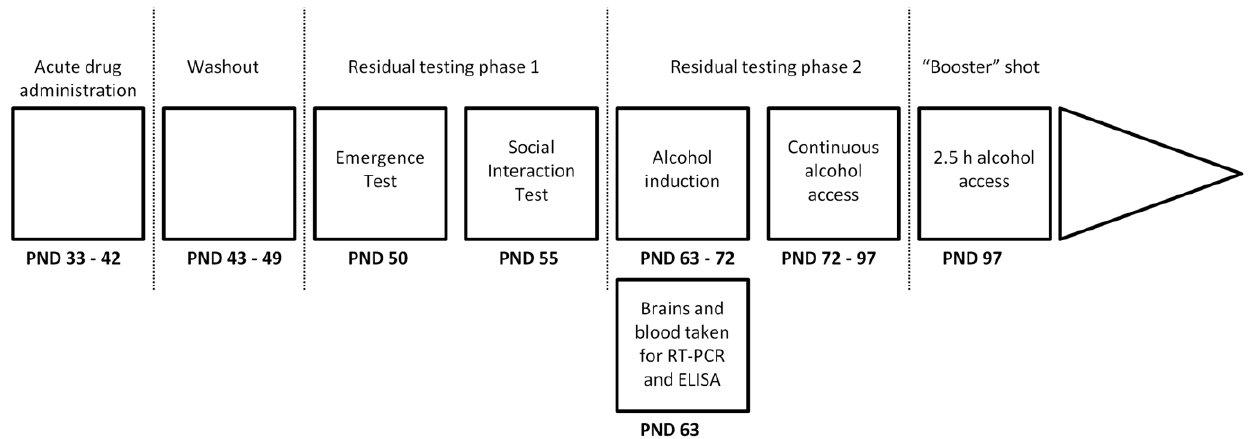
Figure 1. Experimental procedures. There were 24 VEH and 24 OT subjects for inital drug administration, washout and residual testing. Eight VEH and Eight OT subjects from the initial 48 subjects then underwent alcohol induction on PND 63–72 and were used in the subsequent experiments conducted between PND 72–97. Another five VEH and five OT subjects taken from the initial 48 subjects were culled on PND 63 and their brain and blood was later analysed. Abbreviations: VEH=vehicle; OT=oxytocin; PND=post natal day.